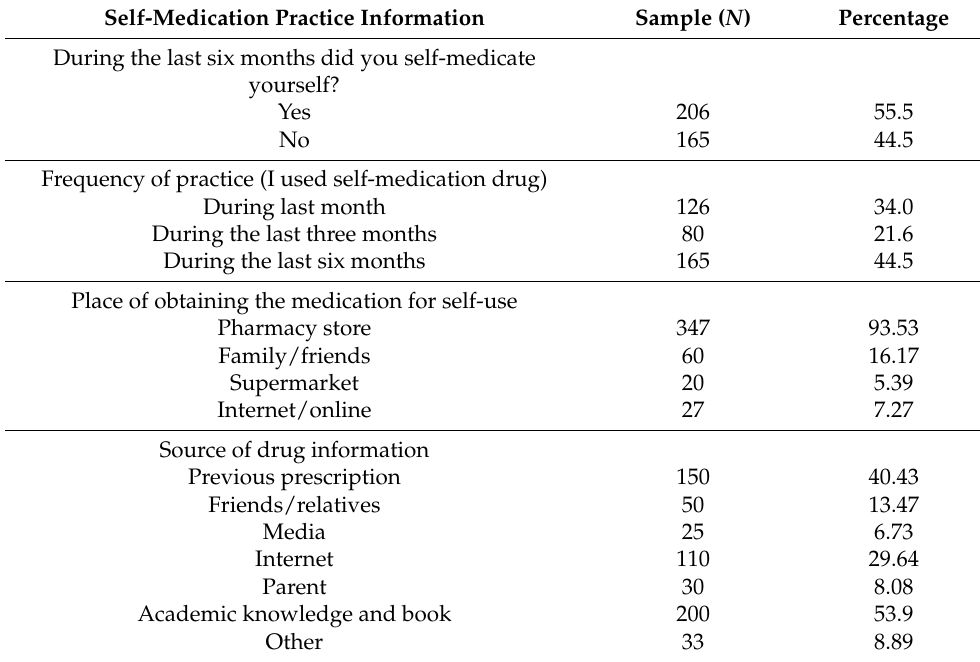
Table 3. Self-medication (SM) practice among students of